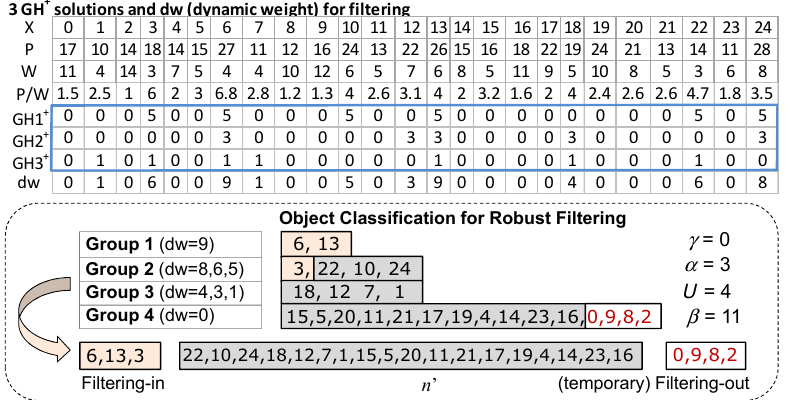
Figure 13. An example ( n = 25, m = 2, C = (30, 40)) and object classification for knapsack 1 ( K 1 ).